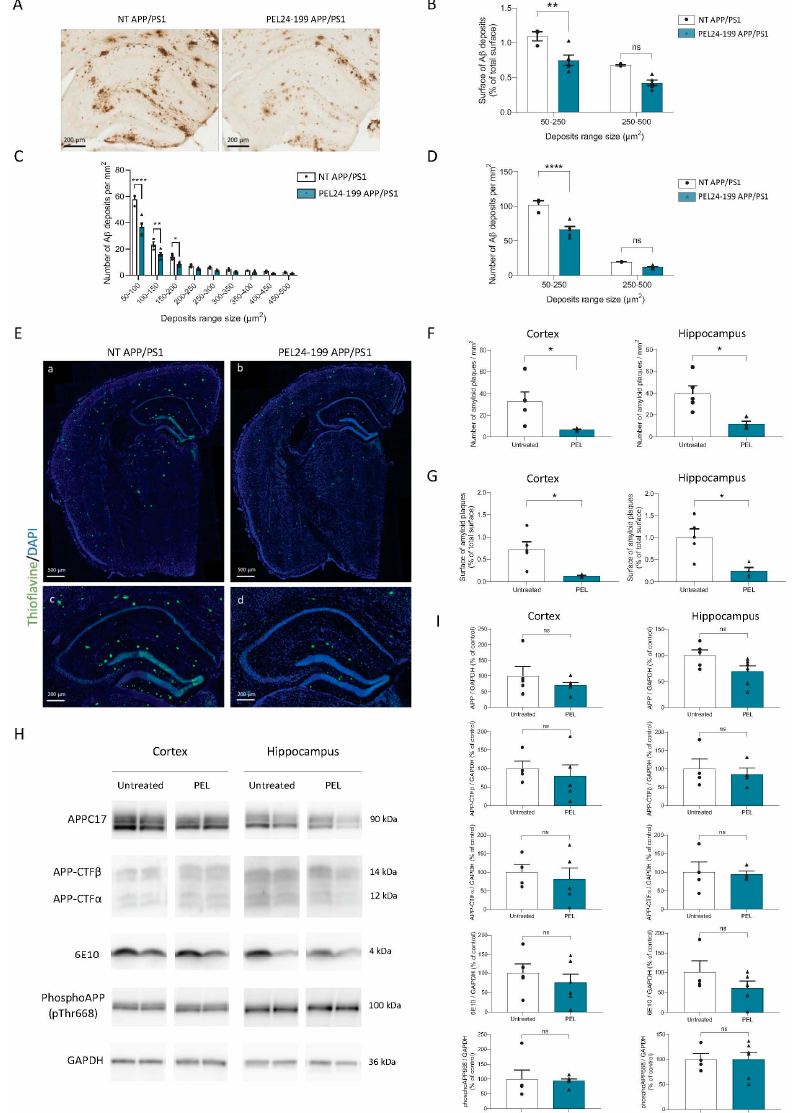
Figure 2. PEL24-199 decreases A β deposits and amyloid plaque burden in APP/PS1 mice. ( A ) Representative images of 4G8 staining in the hippocampus of a twelve months-old APP/PS1 treated with water or PEL24-199. Scale bar = 200 µm. A β deposit distribution ( B ), size, and number ( C , D ) were examined in the hippocampus and the cortex of APP/PS1 mice treated or not with PEL24-199. We found that the treatment with PEL24-199 significantly reduced both in the cortex and hippocam- pus the surface of A β deposits ( B ) and the density of plaques of lower size (between 50–250 µ m 2 ) as compared with APP/PS1 untreated animals (50–250 µ m 2 , p < 0.0001 using Two-Way ANOVA; n = 4–5 per group) ( C – E ) Representative images of Thioflavin-S (green) and DAPI (blue) staining in the hippocampus of a twelve months-old APP/PS1 treated with water or PEL24-199. Upper panels: scale bar = 500 µ m; Lower panels: scale bar = 200 µ m. The number ( F ) and surface ( G ) of Thioflavin-S-positive plaques per mm 2 were investigated in the cortex and hippocampus of APP/PS1 mice treated or not with PEL24-199. Both in the cortex and hippocampus, the surface and a number of amyloid plaques were significantly decreased. Significance at the Mann-Whitney statistical test is indicated by *: p < 0.05, ** p < 0.001, **** p < 0.0001, and ns as not significant. ( H , I ) Western blot analysis was performed in the cortex and hippocampus of water, and PEL24-199-treated APP/PS1 mice. The analysis did not reveal any change in total APP, Carboxy-terminal fragments (CTFs), the A β peptide, or phosphorylated APP at Thr668 protein levels (n = 5–6 per group). ns indicates no significance in the Mann-Whitney statistical